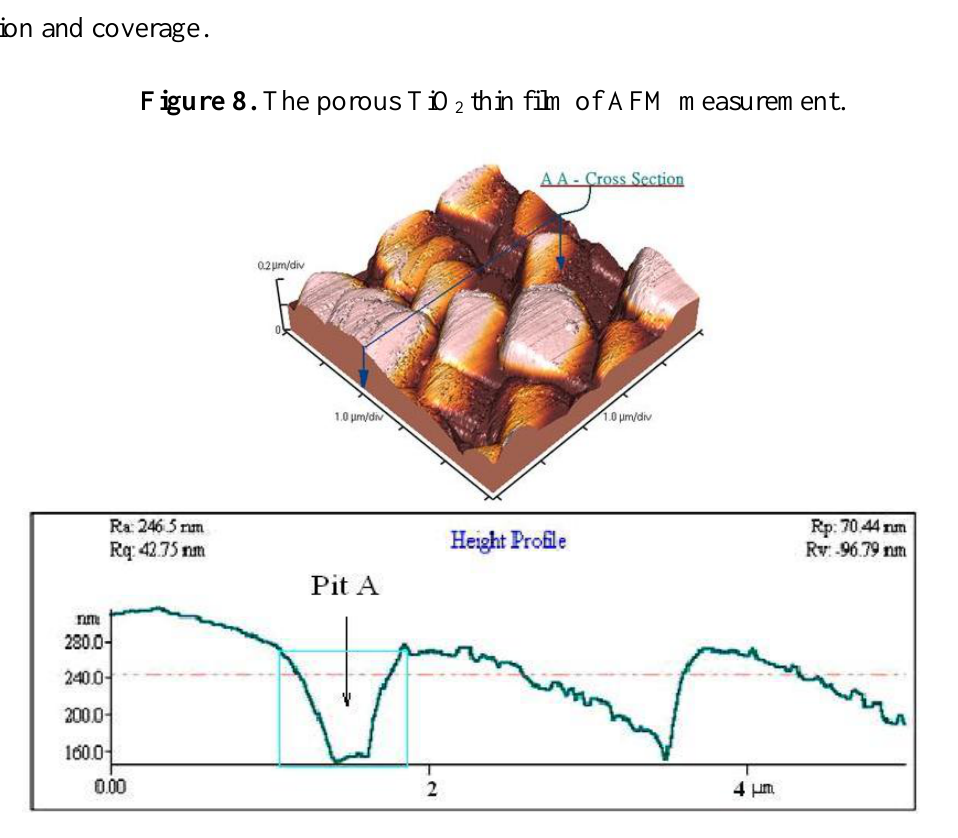
Figure 8. The porous TiO